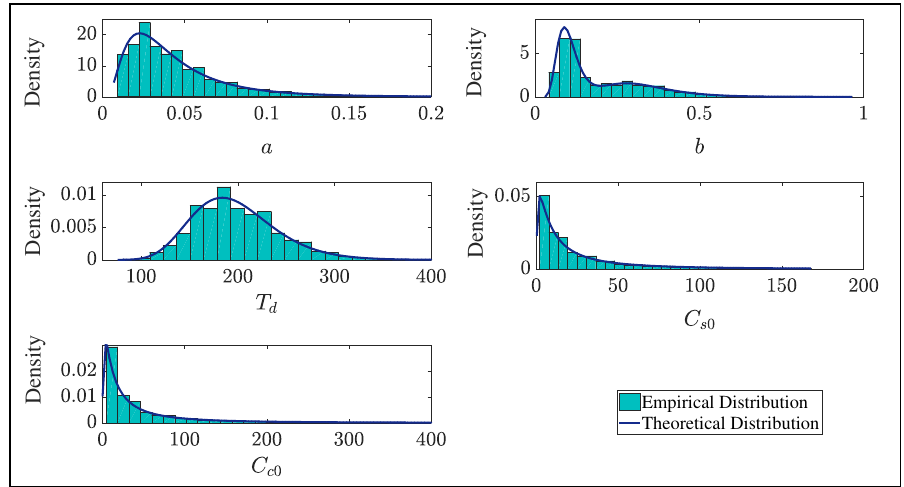
Figure 5. Empirical and theoretical distribution of the estimated values for each parameter of the model (6). The distribution for parameter b clearly exhibits a bimodal trend, confirmed by evaluating Warren Sarle’s bimodality coefficient (BC) which for the distribution of the estimated values for parameter b is > 0.5 (0.7).